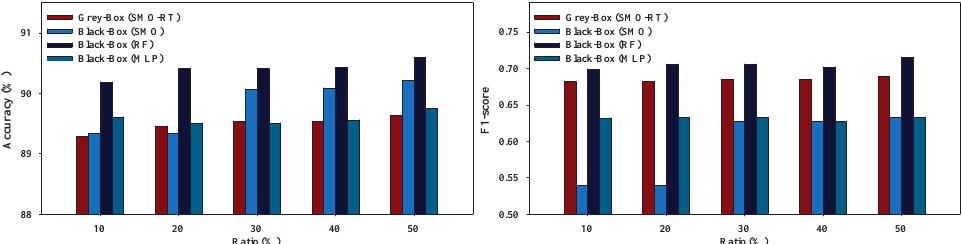
Figure 12. Box-plot with performance evaluation of Grey-Box and Black-Box models for Bank dataset.